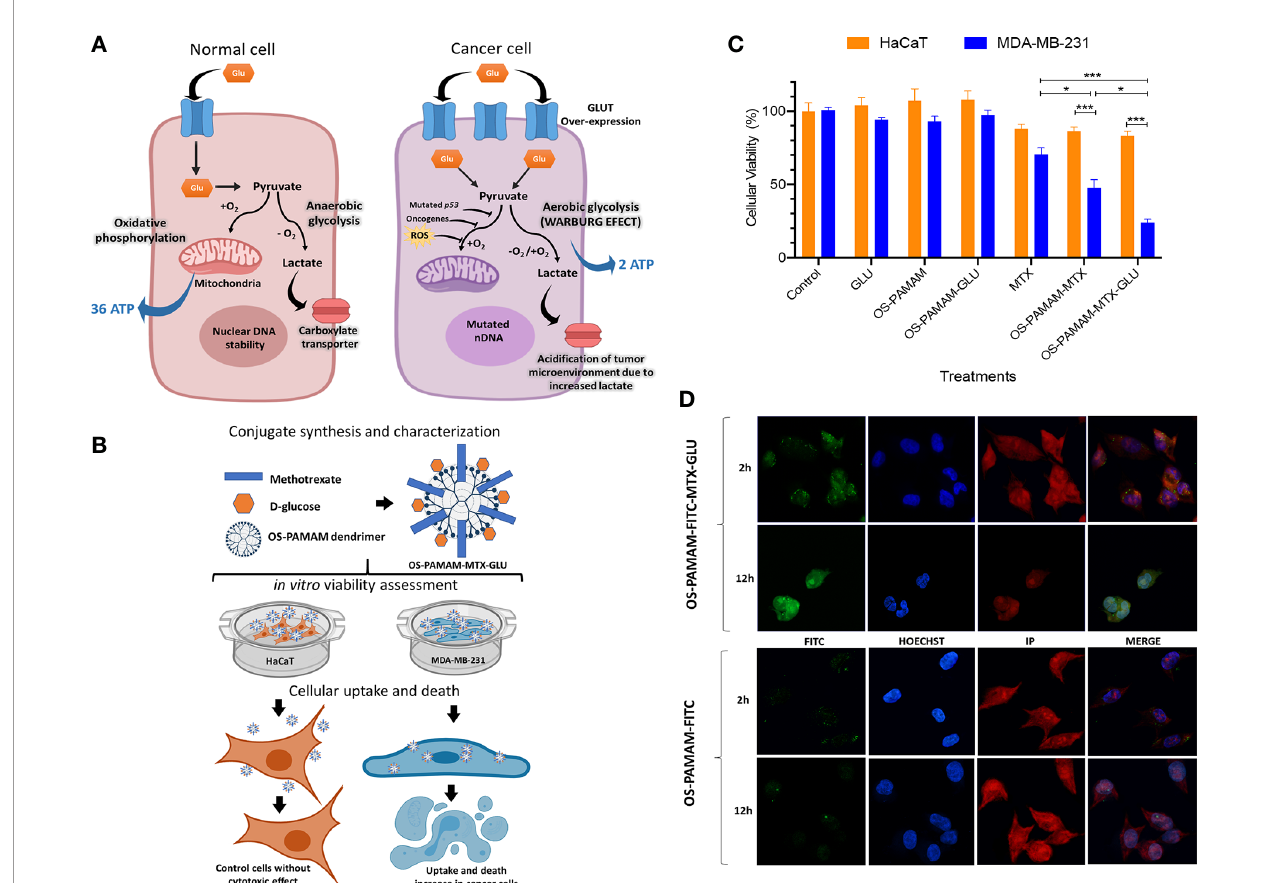
FIGURE 1 | A graphical representation of Warburg effect in cancer and experimental demonstrations of the improvement of glycosylated drug delivery systems for target cancer therapy (A) Metabolic differences between normal and cancer cells. In the presence of O 2 , normal cells metabolize glucose in pyruvate followed by oxidative phosphorylation in the mitochondria generating 36 ATP per glucose molecule. In the de fi ciency of O 2 , pyruvate is transformed to lactate via anaerobic glycolysis generating 2 ATP per glucose molecule. In cancer cell, mutations in mtDNA, nDNA or absence of p53 gene, presence of oncogenes and ROS suppress oxidative phosphorylation and enhances lactate production via glycolysis even in the presence of O 2 (Warburg effect). (B) Glycosylated PAMAM dendrimers conjugated with methotrexate as a strategy for breast cancer target therapy. (C) Comparison of viability between MDA-MB-231 and HaCaT cell lines. Cells were exposed to OS-PAMAM-MTX-GLU and control treatments at the same concentration of free MTX and GLU was calculated in encapsulation assay for 4 h. Data represent mean ± SD (n = 16). Statistical analysis was performed by two-way ANOVA followed by post hoc Tukey ’ s multiple comparisons test. ***P < 0.001, *<0.02. (D) Confocal images of MDA-MB-231 cells incubated for 2 and 12 h with OS-PAMAM-FITC and OS-PAMAM-FITC-MTX-GLU. For each group, the images from left to right showed the fl uorescence of FITC (green), Hoechst 33342 (blue), and PI (red) stains. Images were acquired at 63×. Data has been contributed and modi fi ed from Torres-Pe ́ rez